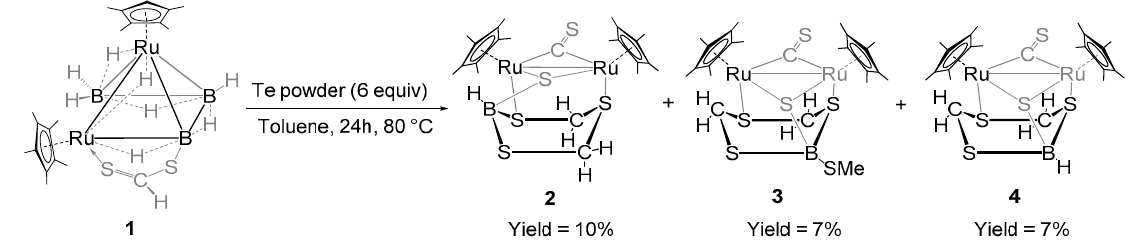
Table 1. Selected structural and spectroscopic data of borinane derivatives and complexes [33,75–78] . Entry 11 B NMR (ppm) a